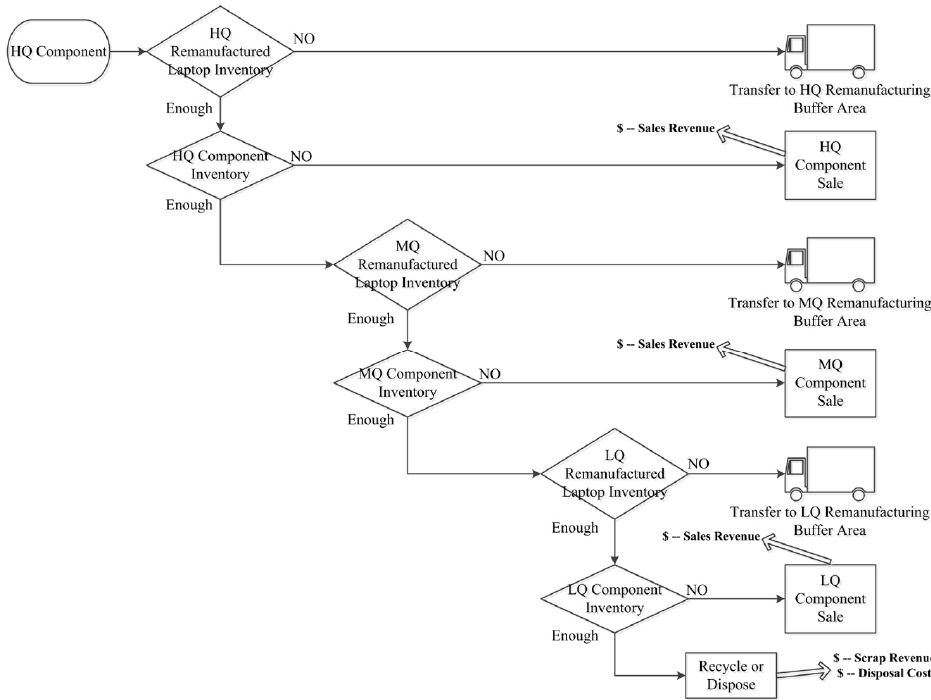
Figure 7. HQ-component flow for recycle, resale, and remanufacturing.